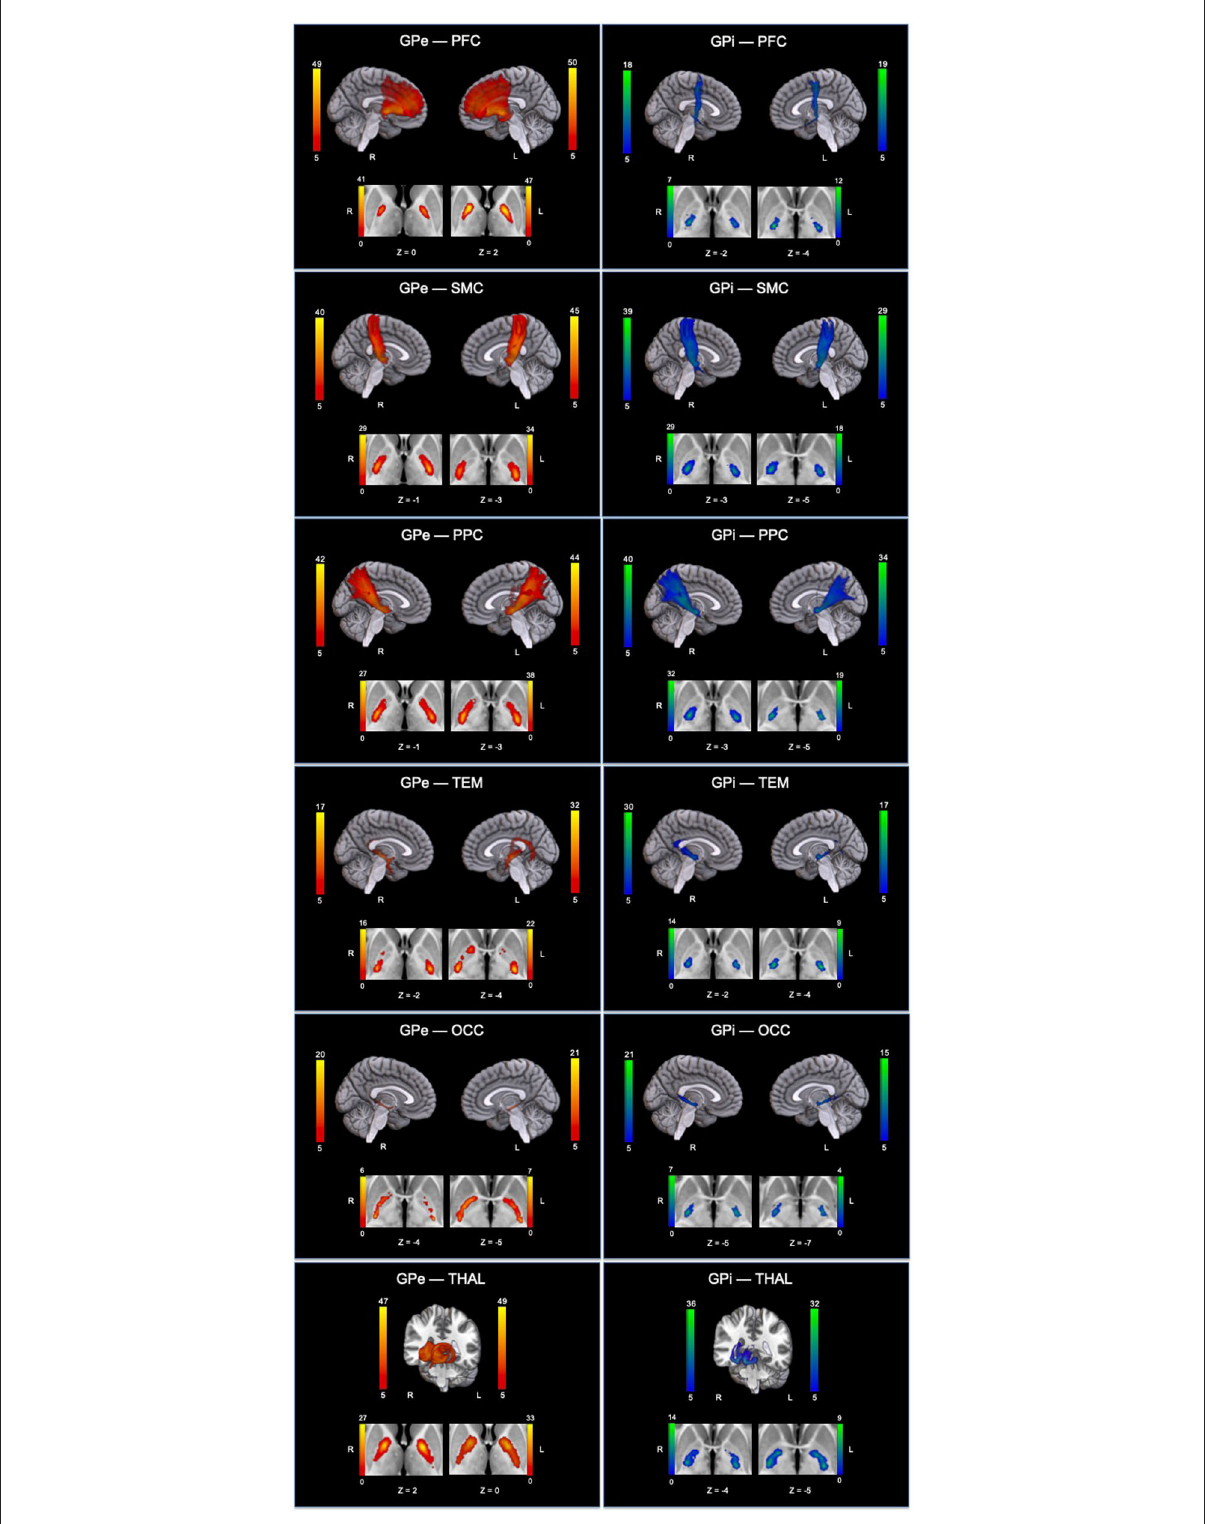
FIGURE4 Topographical patterns of direct pallidal connectivity are depicted. Left column displays GPe connections (red-yellow), and right column displays GPi connections (blue-green). For each panel, the top section shows reconstructed pallidal tracks, and cropped axial images below depict preferred subregional connectivity originating from GPe or GPi. Color bars reflect the number of subjects overlapping (max = 50 subjects). GPe, external globus pallidus; GPi, internal globus pallidus; THAL, thalamus; PFC, prefrontal; SMC, sensorimotor; PPC, posterior parietal; TEM, temporal; OCC, occipital; L, left; R,